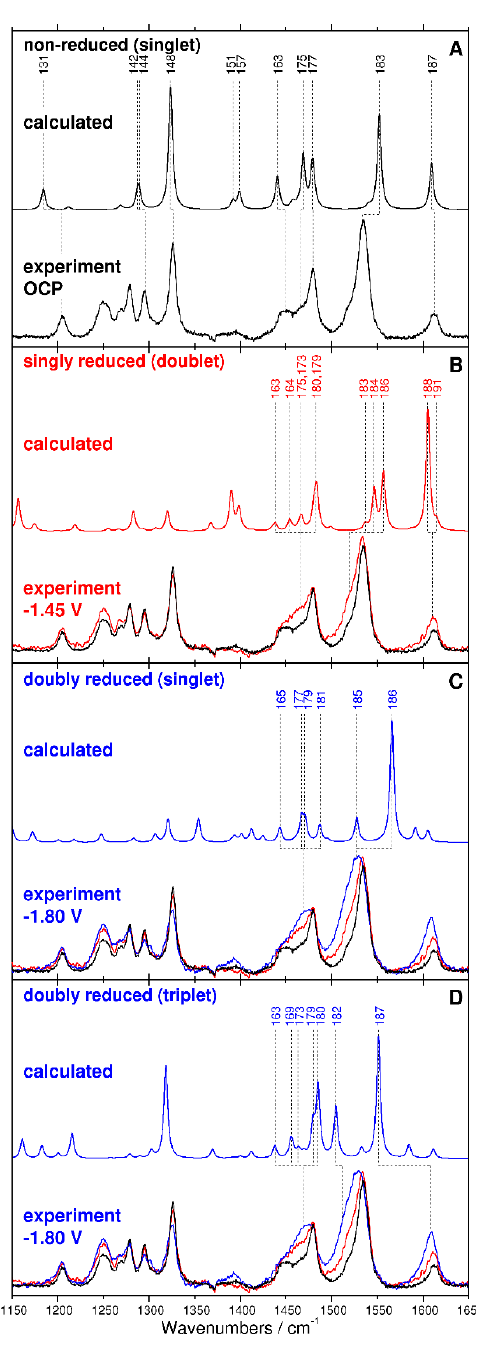
Figure 4. Experimental and calculated RR spectra of non-reduced [Ru(tbtpy) 2 ](PF 6 ) 2 collected at ( A ) ocp and non-reduced singlet, at ( B ) − 1.45 V and spectrum of the singly reduced doublet species, ( C ) spectrum collected at E WE = − 1.80 V and spectrum of doubly reduced singlet species, and ( D ) spectrum collected at E WE = − 1.80 V and spectrum of doubly reduced triplet species, excited at 514 nm. RR spectra recorded upon double reduction of [Ru(tbtpy) 2 ] 2+ closely resemble the spectra of the